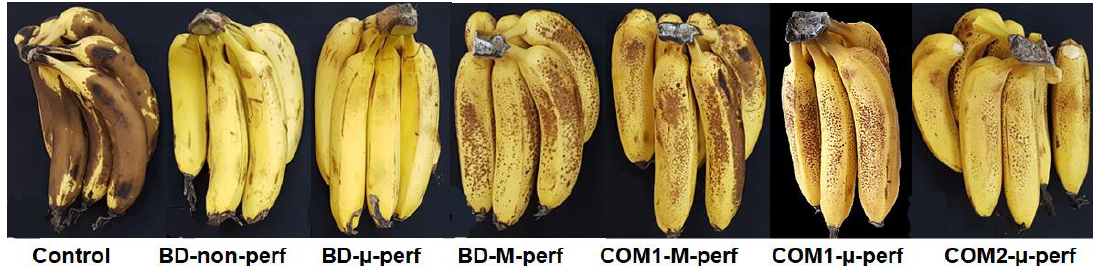
Figure 7. Fruit appearance after three days of simulated distribution at 15 °C and five days of shelf life/home storage at 24 °C. Package designations are the same as in Figure 2.